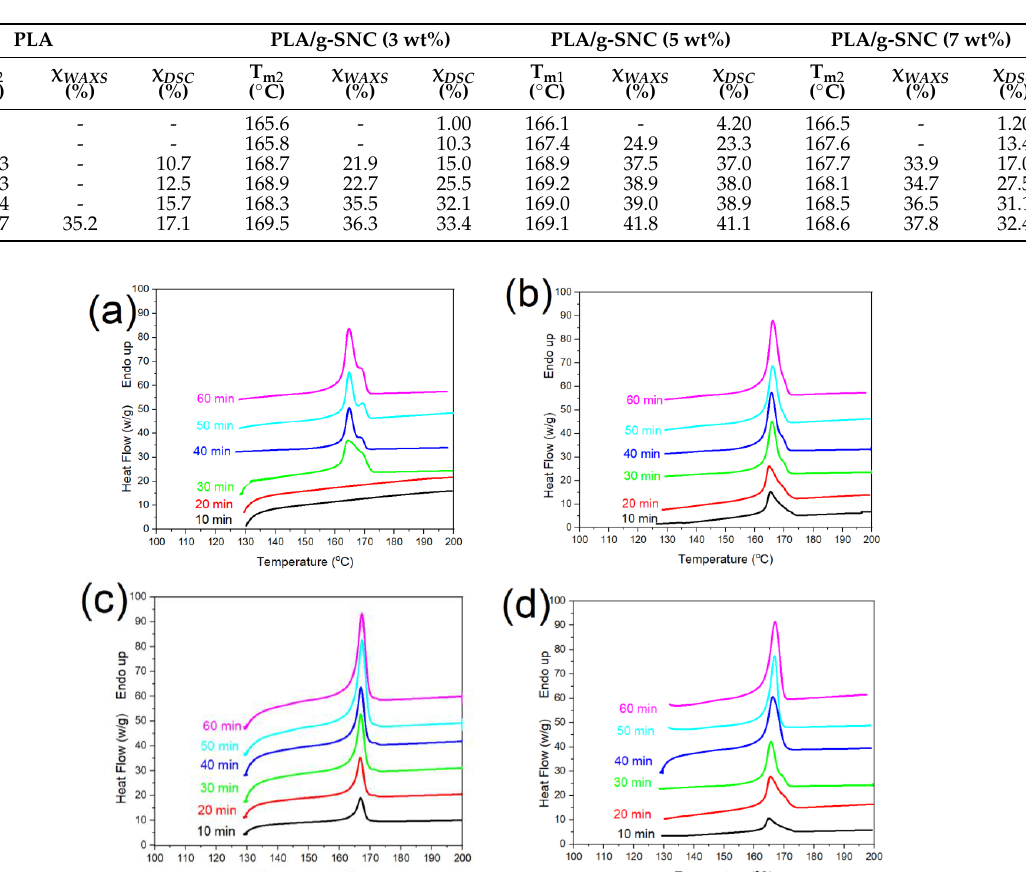
Table 1. DSC and WAXS data of PLA and PLA/g-SNC nanocomposite, which are crystallized for different crystallization times (10–60 min) at T c = 130 ◦ C.